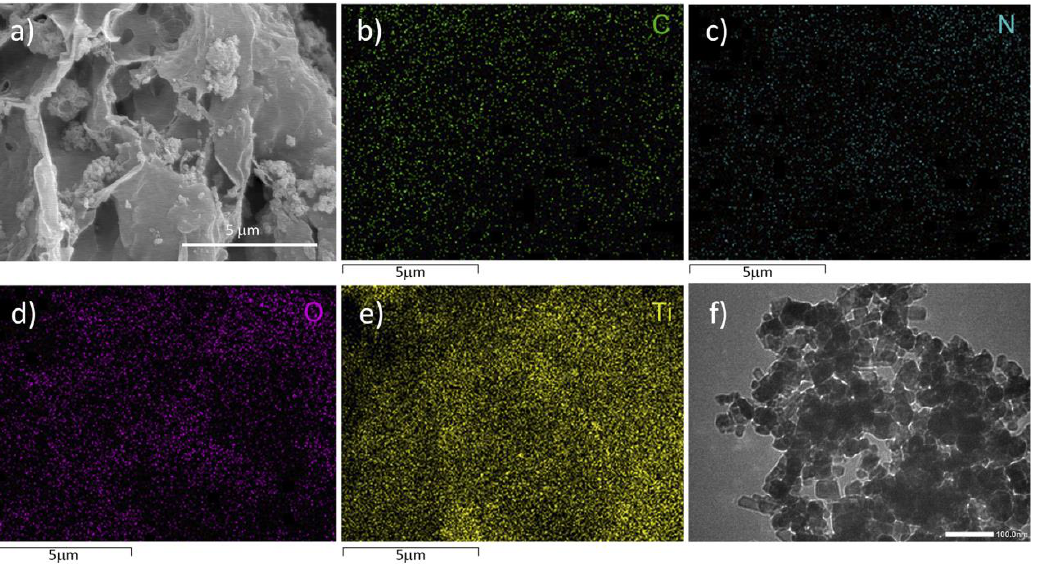
Figure 2. SEM ( a ) and TEM ( f ) images of BCBT; ( b – e ) EDX elemental mappings of C, N, O, and